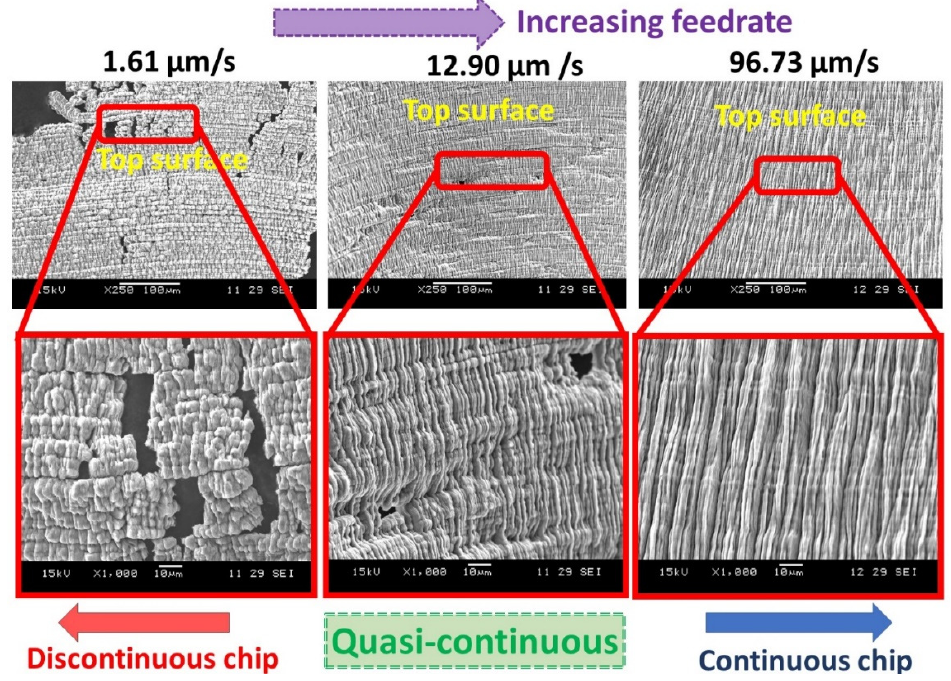
Figure 5. Free ( top ) surface of the Al alloy microchips noticed in SEM image analysis.